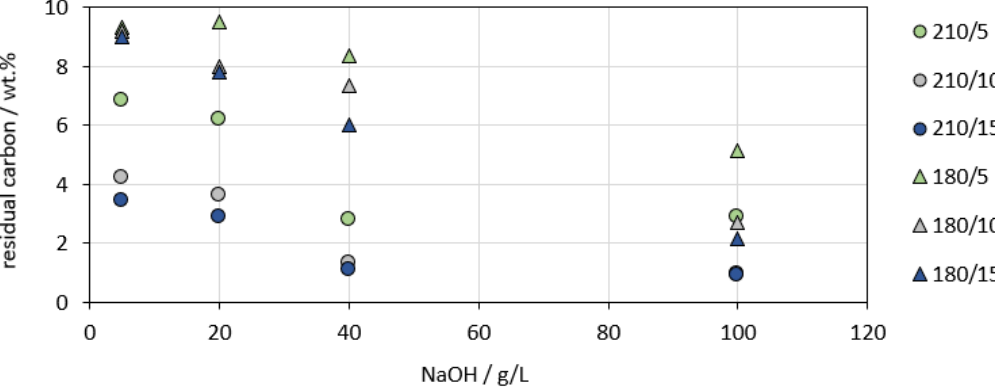
Figure 7. The carbon content in the leach residue of series A1 and A2; constants: 1 h, 800 rpm, S/L: 0.1.